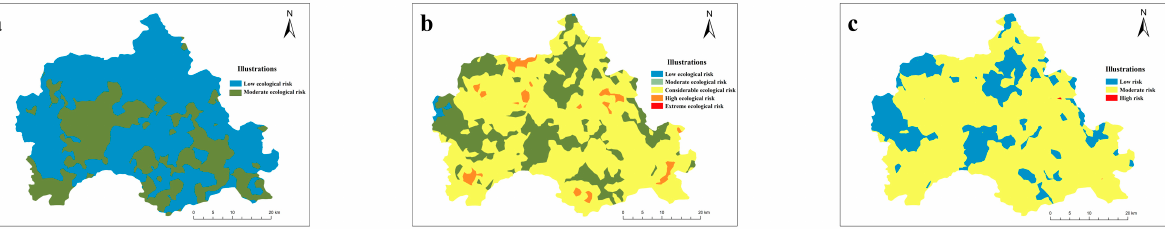
Figure 9. ( a ) Map of ecological risk distribution in the study area (Cd), ( b ) Map of ecological risk distribution in the study area (Hg), and ( c ) Integrated potential ecological risk map of the study